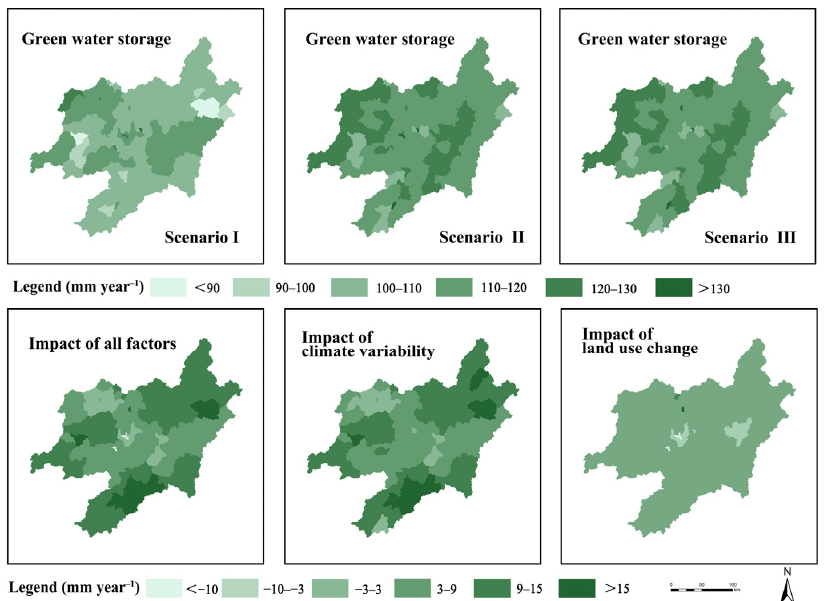
Figure 9. Spatial distribution and change in GWS in the upper Ganjiang River basin under the individual or combined influence of climate and land-use change.